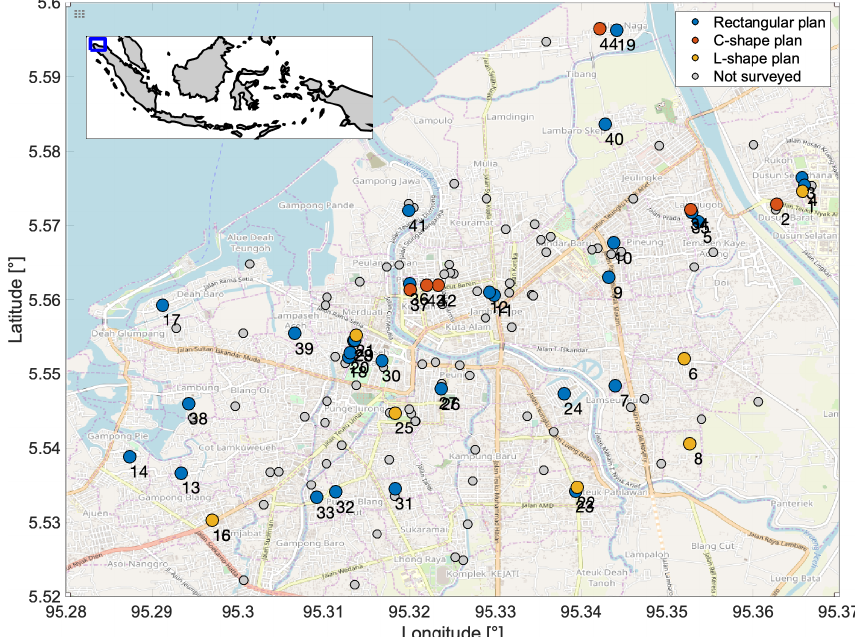
Figure 4. Map of the school buildings in Banda Aceh, including non-surveyed ones. Background map by © OpenStreetMap contribu-